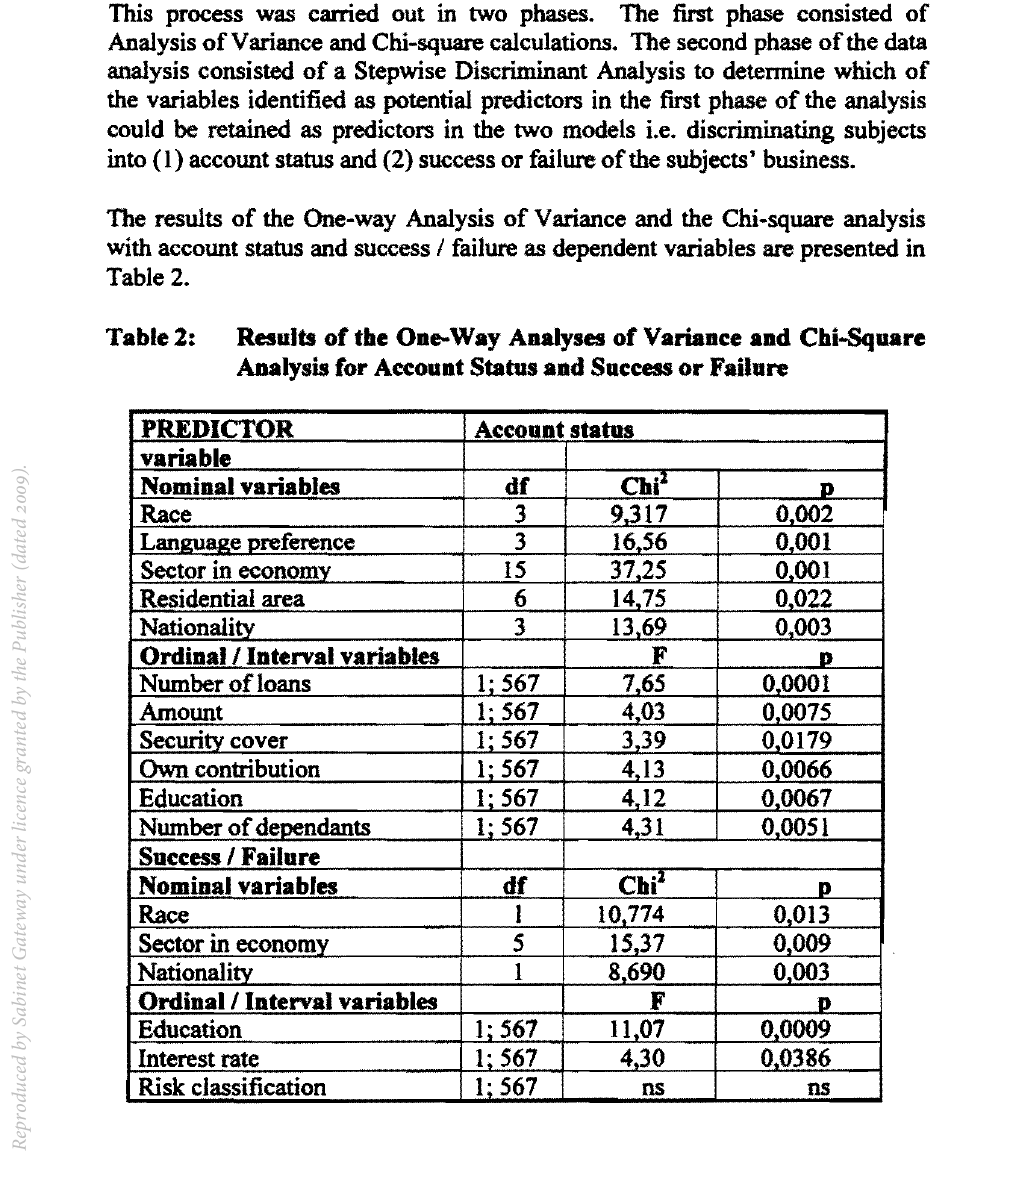
Results of the One-Way Analyses of Variance and Chi-square Analysis for Account Status and Success or